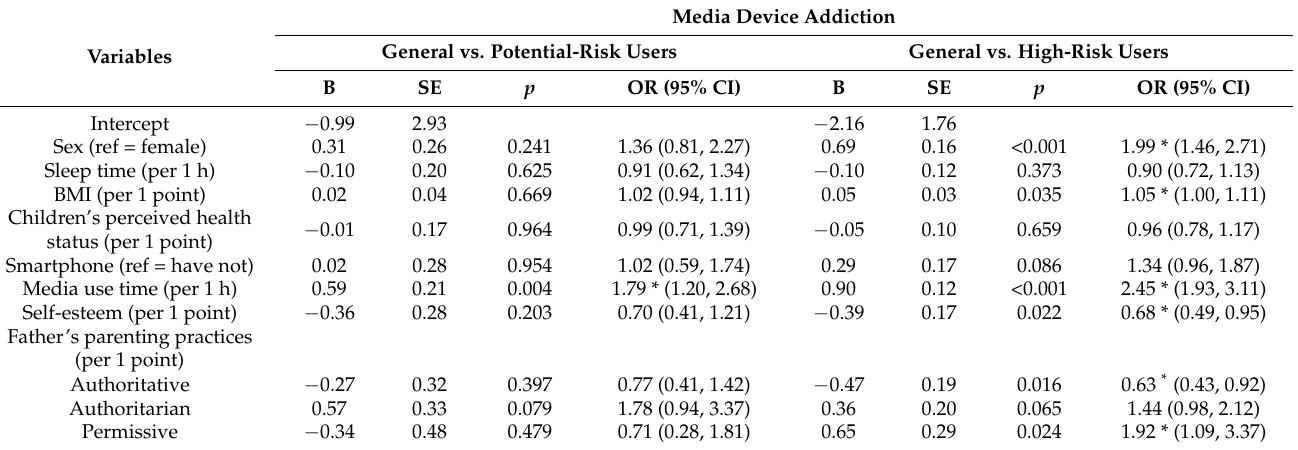
Table 4. Multinomial logistic regression for predictors of media device addiction among younger school-aged